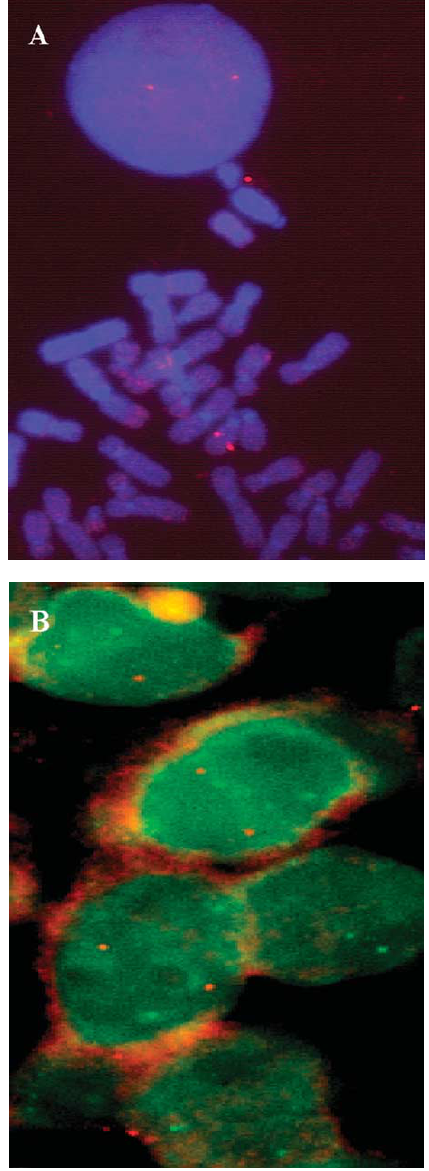
Fig. 2. Fluorescence in situ hybridization for HIF -1 α (A) FISH analysis on normal metaphase chromosome preparation shows that HIF -1 α is present in two copies on chromosome 14. (B) Two color FISH analysis of an invasive breast cancer core on a tissue microar- ray shows the presence of two copies of HIF -1 α (red) and the lo- cus specific control probe for chromosome 14 (green) respectively (Magnification ×